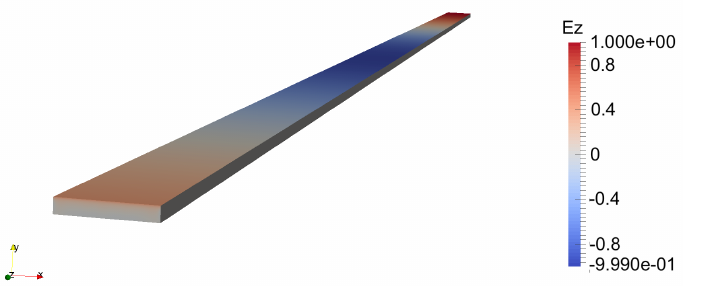
Figure 6. Simulated electric field when the incident field is polarized in the direction of the fibers for ω 1 = 2.45 GHz.